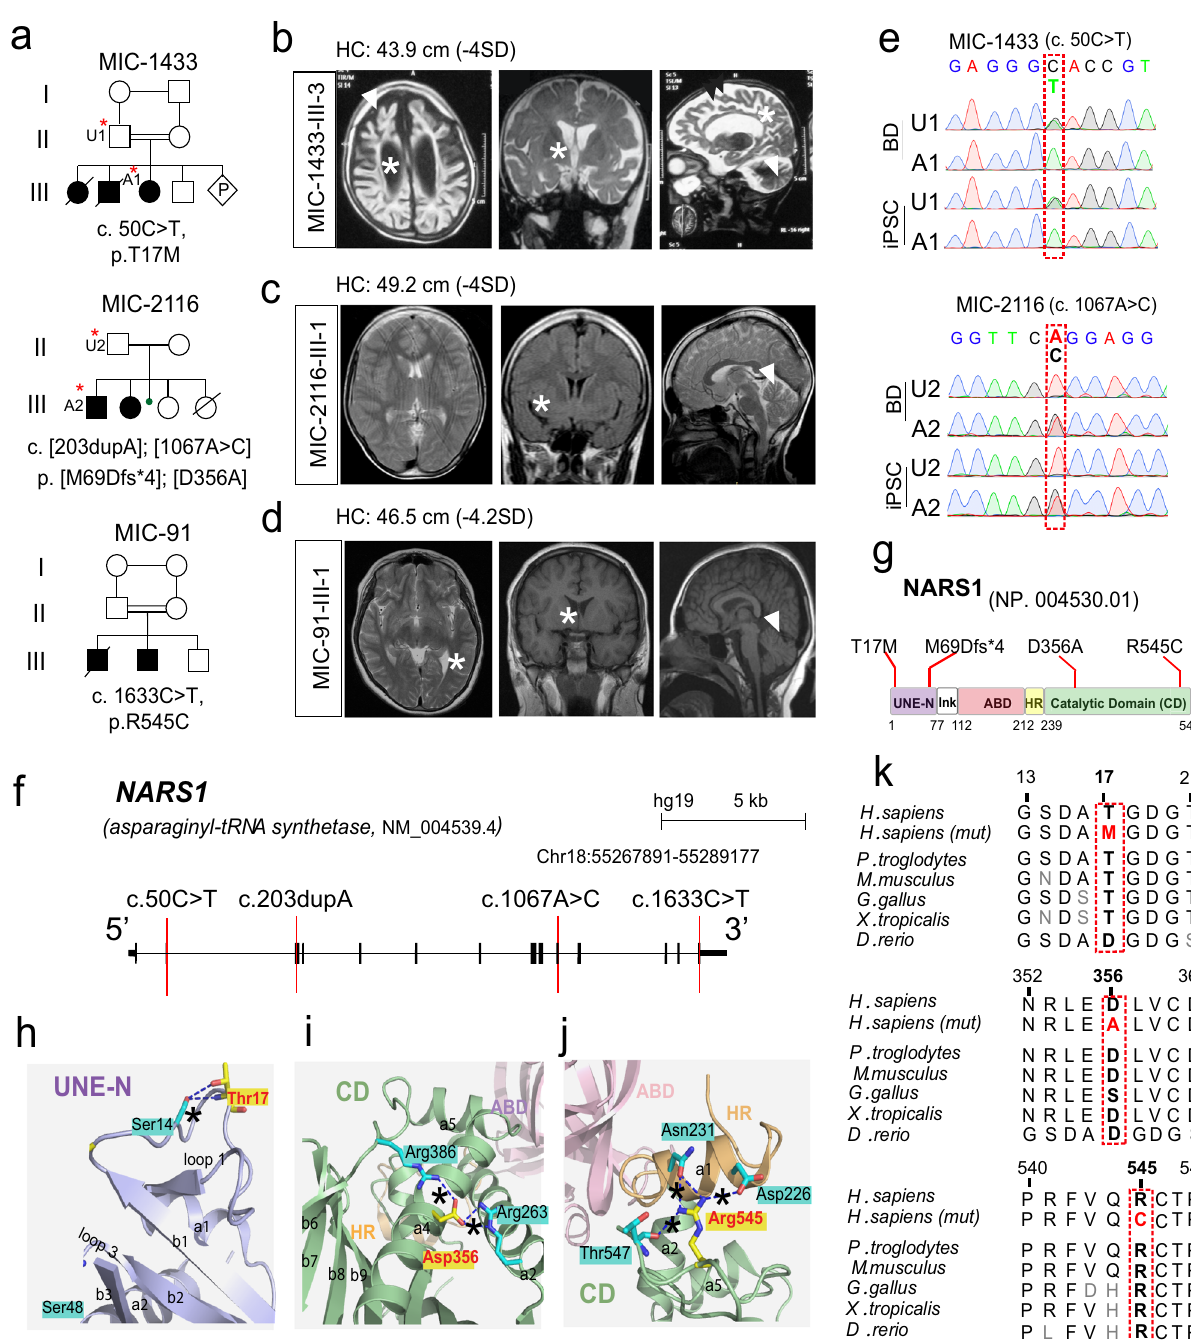
Fig. 1 Identi fi cation of NAR S 1 mutations in families with microcephaly. a Pedigrees MIC-1433, MIC-2116, and MIC-91. Double line: consanguinity. Square: male; Circle: female; fi lled: affected; hash line: deceased; diamond: pregnant. U1, A1, U2, A2 (red asterisks) represent patients cell lines used in the following fi gures. b – d MRIs for affected individuals showing ventriculomegaly (asterisks) and cerebral and cerebellar atrophy (arrows). Arranged in axial, coronal, and sagittal planes . e Chromatogram of mutations. f N ARS1 genomic organization. Red lines: mutation position according to NM_004539.4. g NARS1 domains: N-terminal extension (UNE-N, aa1-77), anticodon-binding (ABD, aa112-212), hinge (HR, aa213-239) and catalytic (aa240-548), (h-j). lnk: linker. NARS1 Thr17 ( h ), Asp356 ( i ) and Arg545 ( j ) highlighted. Asterisk (*) indicates hydrogen bond. k Conservation of mutated residue across